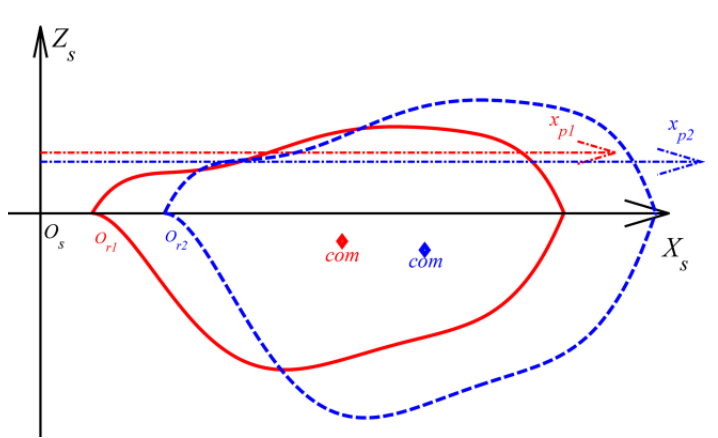
Figure 2. The original (red crude solid line) and dynamically scaled wing planform (blue color dashed line) of fruit fly wing.